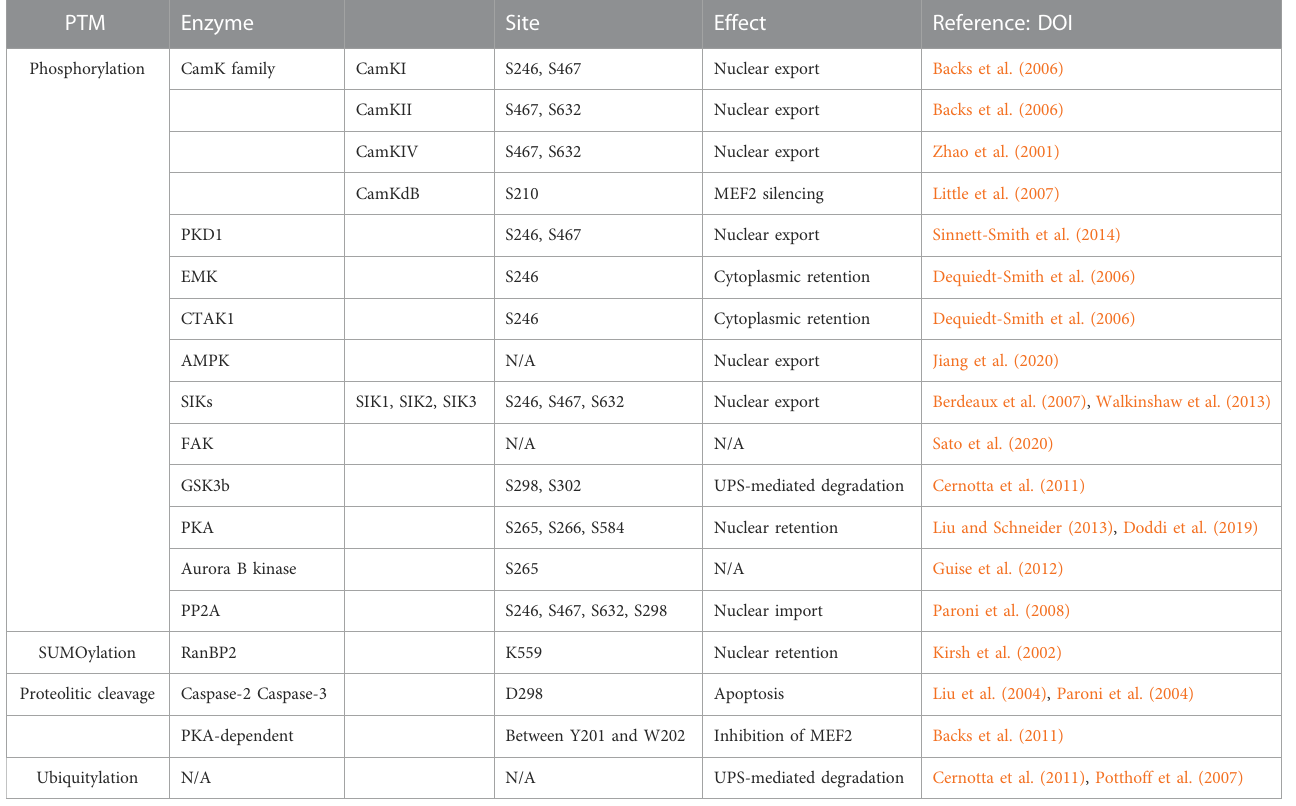
TABLE 2 Main PTMs regulating HDAC4